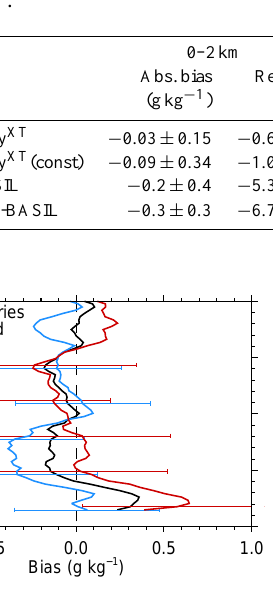
Figure 9. Absolute bias and standard deviation (error bars) be- tween the RS and Polly XT distinguished by different trajectories. The black line indicates the bias considering all trajectories.